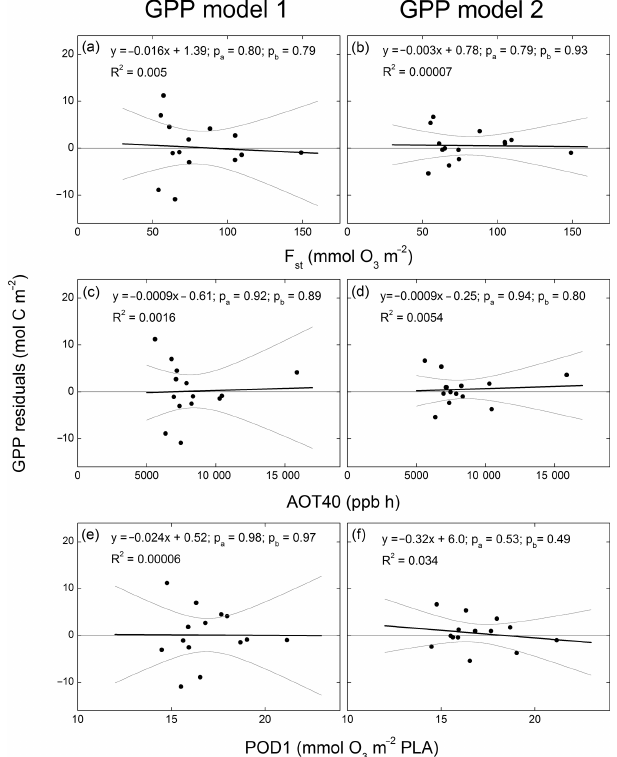
Figure 9. The residuals of growing season gross primary produc- tivity (GPP) as a function of (a, b) the total stomatal O 3 flux over the growing season ( F st ) , (c, d) AOT40, and (e, f) POD 1 . PLA is the projected leaf area. The negative residuals indicate model over- estimation of GPP. GPP model 1 was trained without days with the highest stomatal O 3 uptake, whereas GPP model 2 was trained to test for possible lag effects of O 3 on GPP. The black lines are the fitted linear regression lines and the grey lines mark the 95% confi- dence bands. Also shown are the p values for the tests of the slope and intercept from the regression y = ax + b being different from 0 ( n =